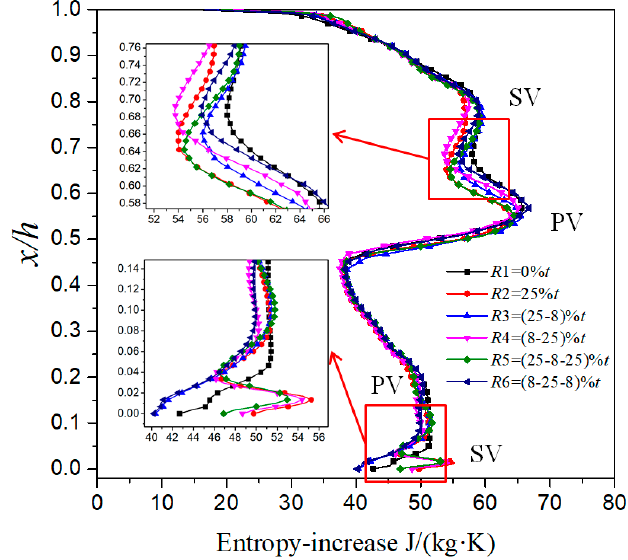
Figure 13. Radial distribution of entropy-increase at 110% axial chord length of S2.